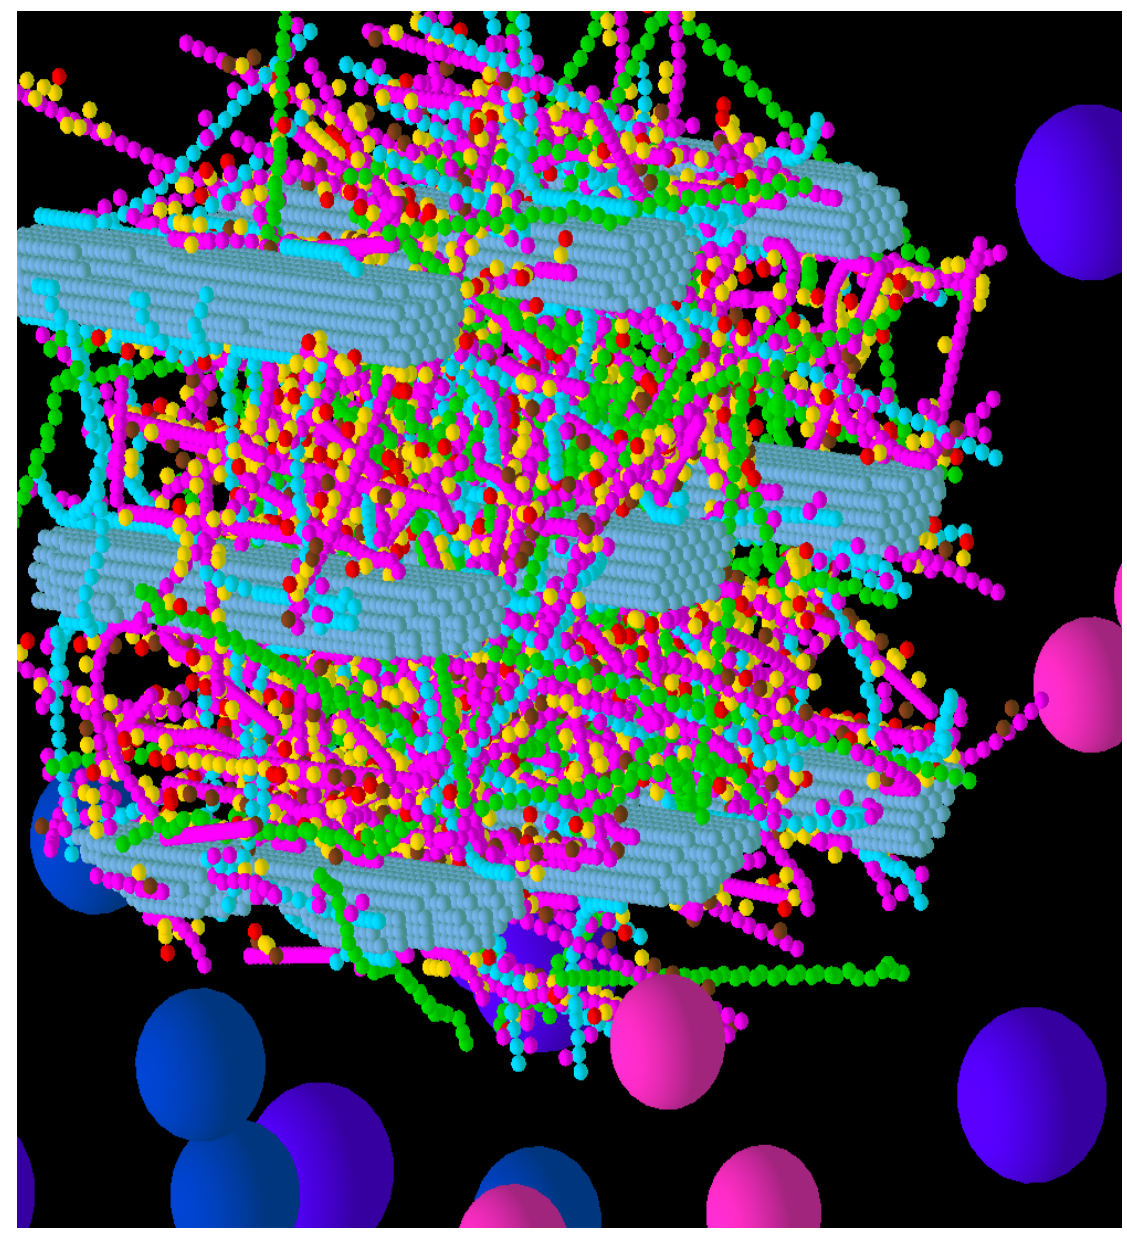
Figure 6. The degraded perennial ryegrass MCW after the simulated enzyme action showing degradation of hemicelluloses and cellulose at the periphery of the wall after a simulation run involving a combination of Cel51A, Cel9D and endoxylanase 1. Glucose, xylose, arabinose, glucuronic acid, ferulic acid and galacturonic acid are represented by the smaller spheres coloured blue, magenta, yellow, brown, red and green respectively. Larger spheres coloured purple, blue and magenta represent Cel51A, Cel9D and endoxylanase 1,